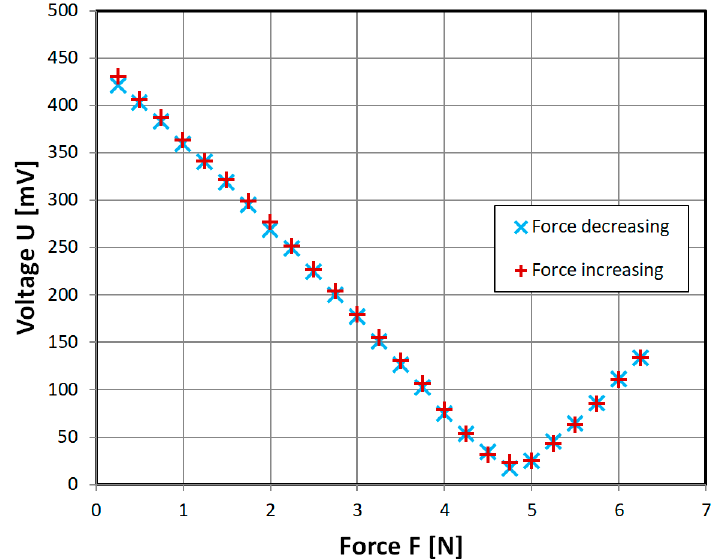
Figure 11. Obtained experimental characteristic of developed ‘straight’ sensor, with variable mutual inductance omitted. Sinusoidal driving current of 700 mA, 432 Hz.